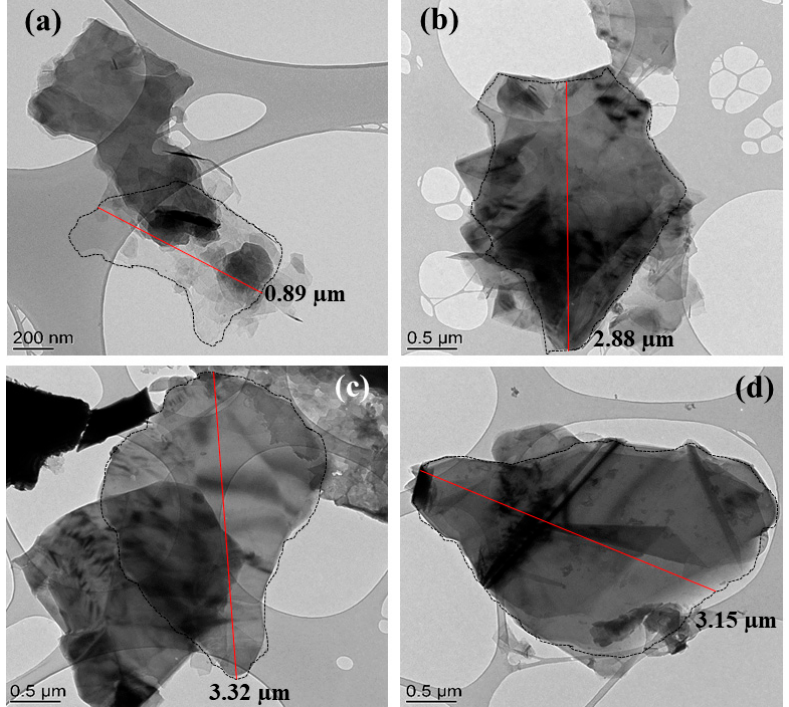
Figure 1. TEM images of ( a ) pristine h BN electrode materials and h BN samples after modification with ( b ) 2.5, ( c ) 5, and ( d ) 10 wt% BaF2